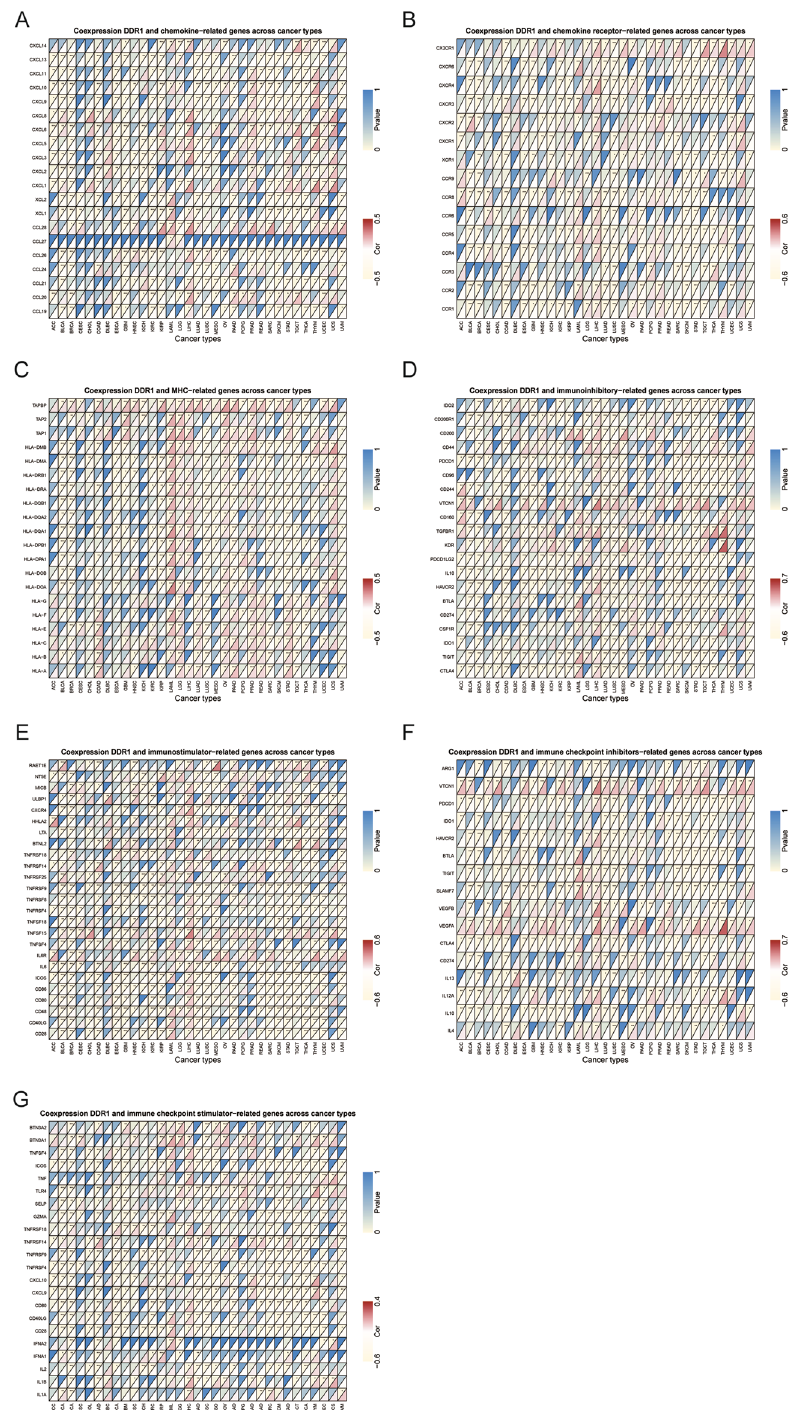
Figure 9. Co-expression of DDR1 and immune-related genes. * P < 0.05, ** P < 0.01, *** P <